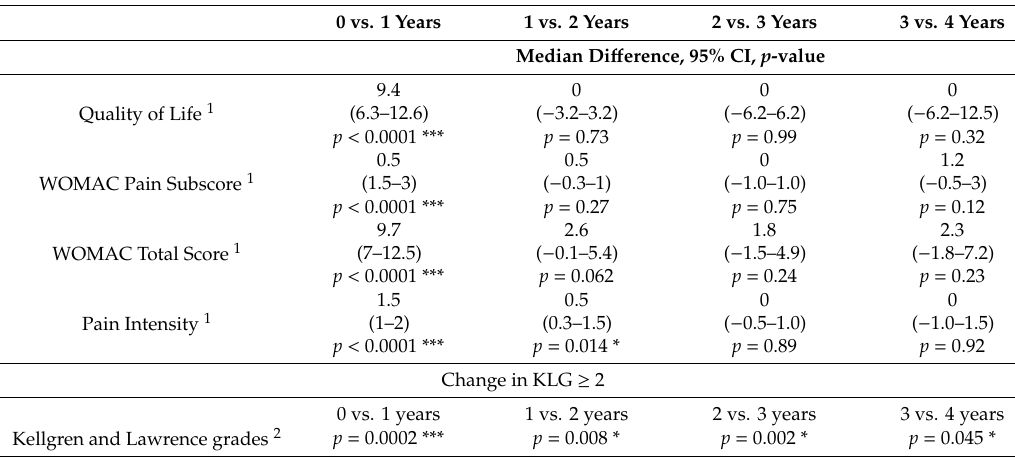
Table 3. Longitudinal comparative data of the 165 study participants at the following time points prior to the total knee replacement (TKR) surgery: 0 years (last follow-up visit without TKR i.e., in the next annual follow-up visit radiographic evidence for a total knee replacement was detected), 1 year (second last visit without TKR, i.e., in the annual follow-up visit, in 2 years, radiographic evidence for a total knee replacement was detected), 2 years (third last visit without TKR, i.e., in the annual follow-up visit, in 3 years, radiographic evidence for a total knee replacement was detected), 3 years (fourth last visit without TKR, i.e., in the annual follow-up visit, in 4 years, radiographic evidence for a total knee replacement was detected) and 4 years (fifth last visit without TKR, i.e., in the annual follow-up visit, in 5 years, radiographic evidence for a total knee replacement was detected) prior to TKR. Quality of life was measured by a subscale of the Knee injury and Osteoarthritis Outcome Score (KOOS) 0–100 (worst to best). Functional measures were evaluated by the Western Ontario and McMaster Universities Osteoarthritis Index (WOMAC) Total score 0–100 (best to worst), whereas pain measures relied on the WOMAC pain subscale 0–20 (best to worst). Pain intensity was captured by the numerical rating scale estimating the participant’s pain intensity during the last 30 days 0–10 (best to worst). Values are given as median with the accompanying 25% and 75% quartiles. For comparisons between change in Kellgren and Lawrence grades (KLG) we compared the strata having KLG 0 and 1 versus KLG 2, 3 and 4 (also see Figure